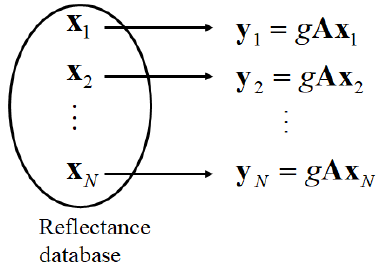
Figure 2. Prediction of observation for each spectral reflectance in the database.